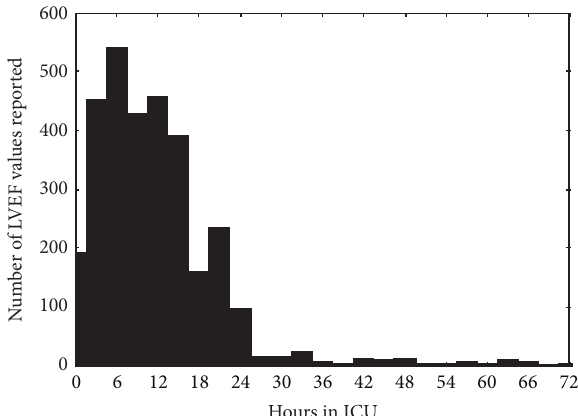
Figure 3: Distribution of the valid numerical values reported for LVEF during the first 3 days of stay in the ICU, referring to the time of ICU admission (0 hours).